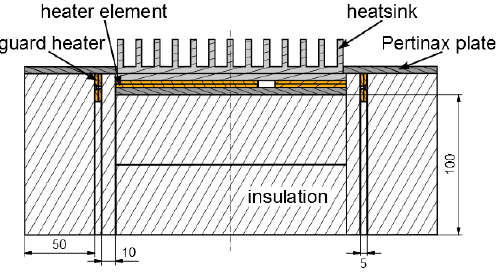
Figure 5. A cross-section of the insulated